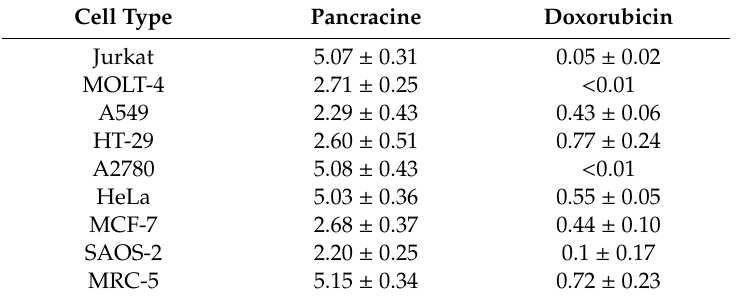
Table 3. IC 50 values of pancracine and doxorubicin in human cancer and non-cancer cells a,b .